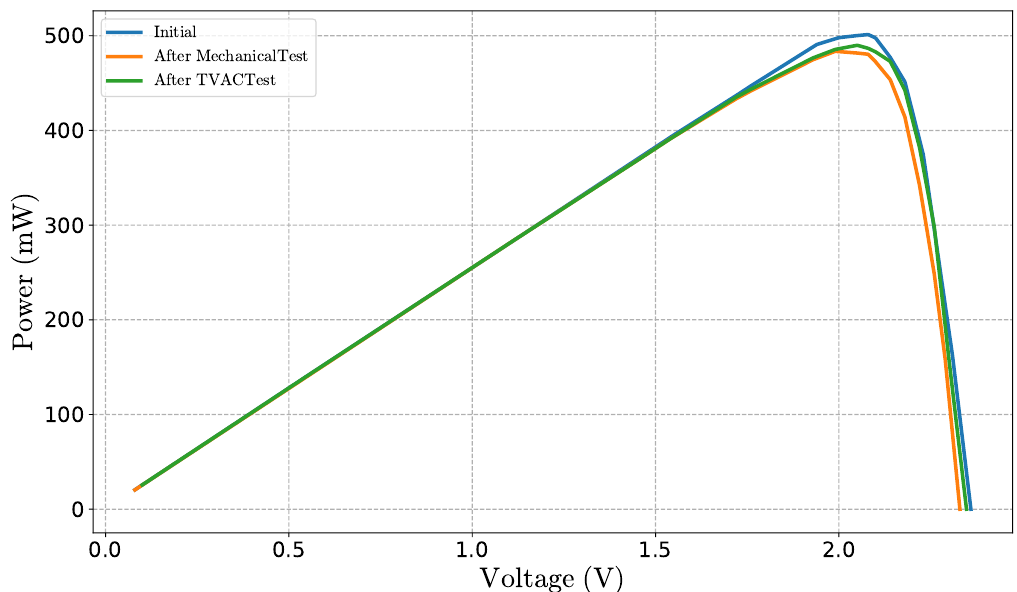
Figure 12. Experimental power–voltage (P-V) curve of one solar cell of the module.